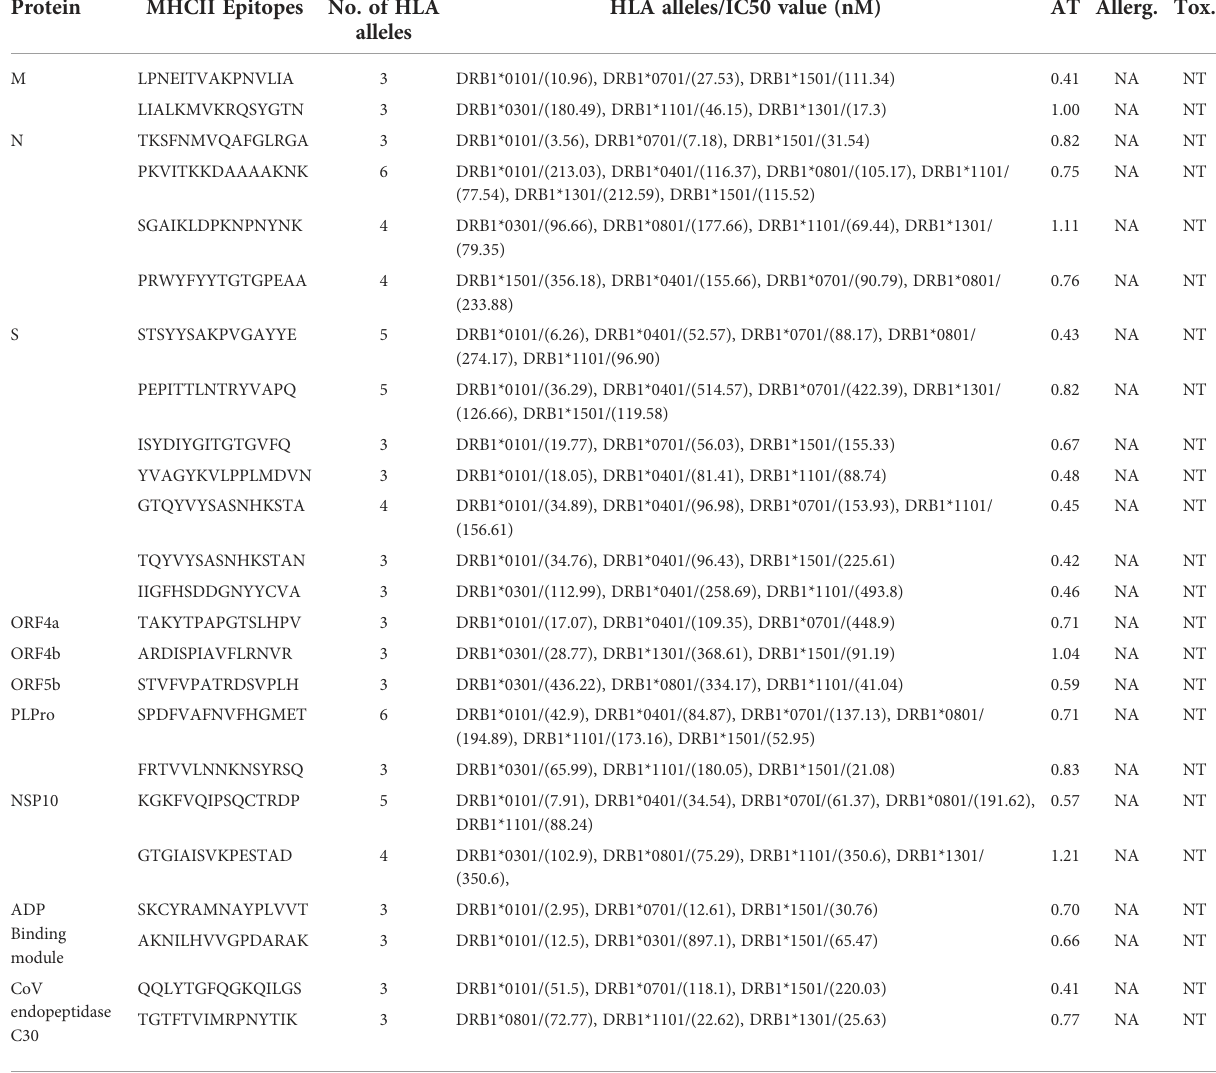
TABLE 4 List of prioritized MHC-II (HTL) binding epitopes by NetMHCIIpan. Protein MHCII Epitopes No. of HLA HLA alleles/IC50 value (nM) AT Allerg. alleles